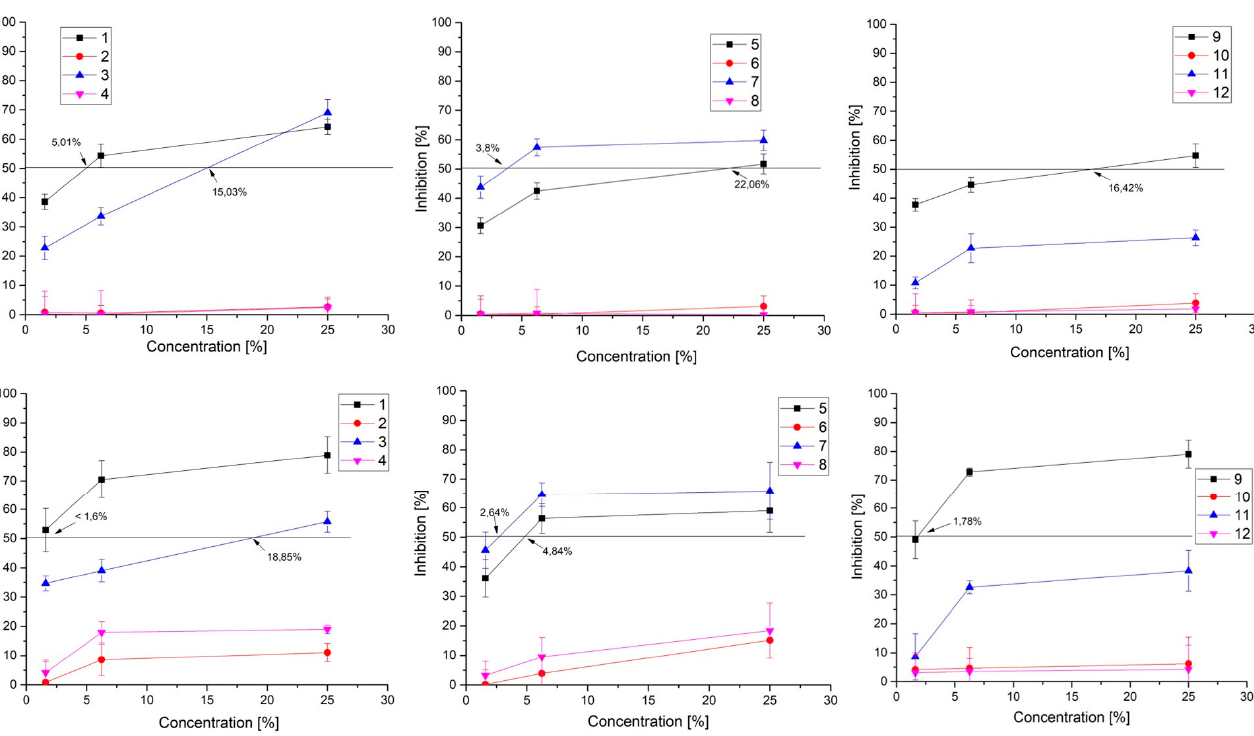
Table 2. Antiviral activity of CFSs from the studied LAB strains HHV-1 and HHV-2 and determination of selective index.